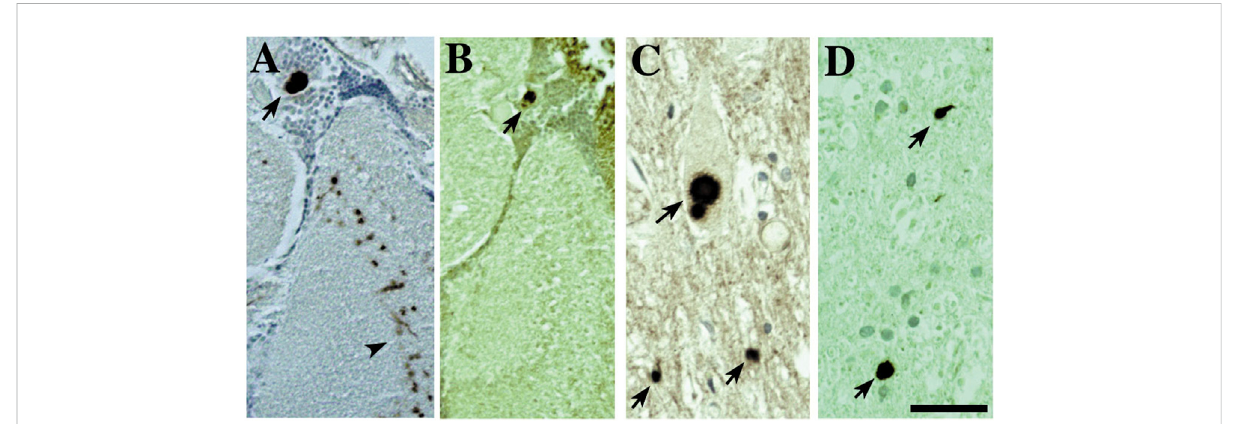
FIGURE 3 The accumulations of toxic disease proteins in the fl y can strikingly resemble the human pathology of the disease. Expression of α -synuclein leads to Lewy-body-like aggregates in the cortex and neurophil that are remarkably similar to the Lewy bodies found in human disease (also (Feany and Bender, 2000; Auluck et al., 2002)). (A,B) Fly tissue showing immunostaining of Lewy-body-like aggregates for (A) α -synuclein and (B) stress- induced Hsp70.Tissue fromaParkinson ’ spatient showing (C) Lewy bodies that immunostain (D) for Hsp70. Bar3 µm. From (Bonini,2002)with